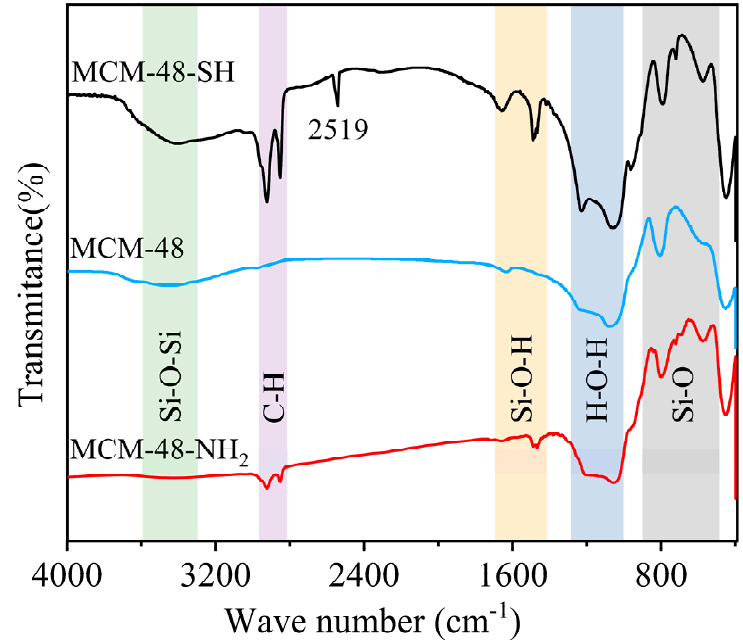
Figure 5. FTIR image of MCM-48-SH, MCM-48, and MCM-48-NH 2 .